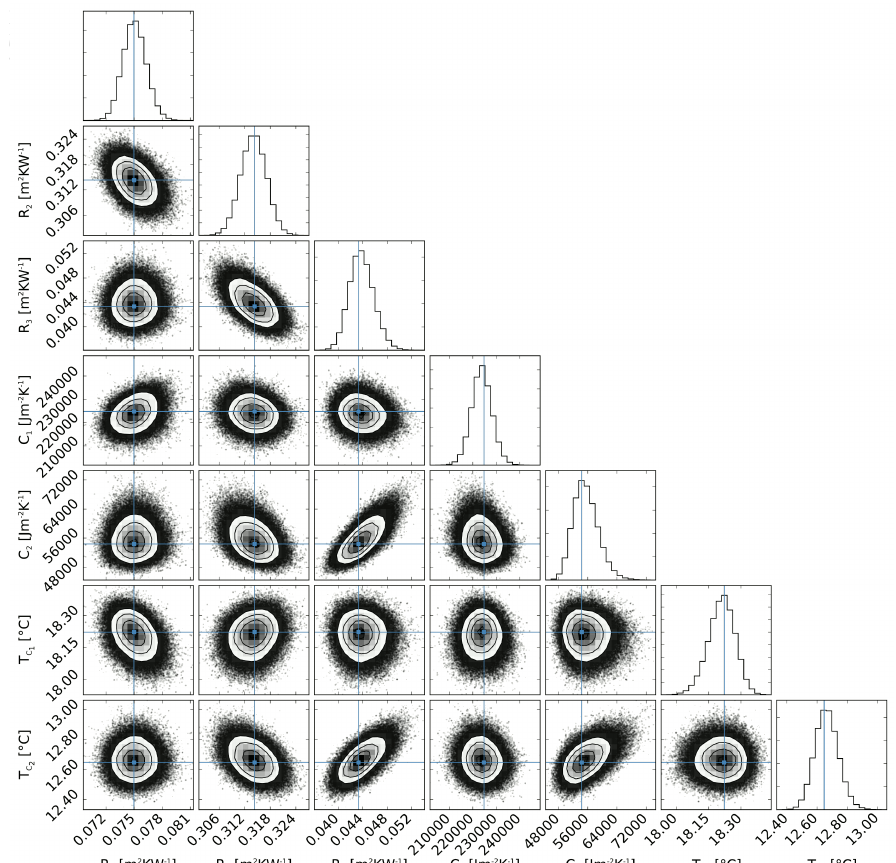
Figure 5. Corner plot of the distribution of the thermophysical properties of the SWall using the 2TM model. The turquoise crossed lines indicate the maximum a posteriori (MAP) estimation used as starting point for the Markov chain Monte Carlo (MCMC) walk.